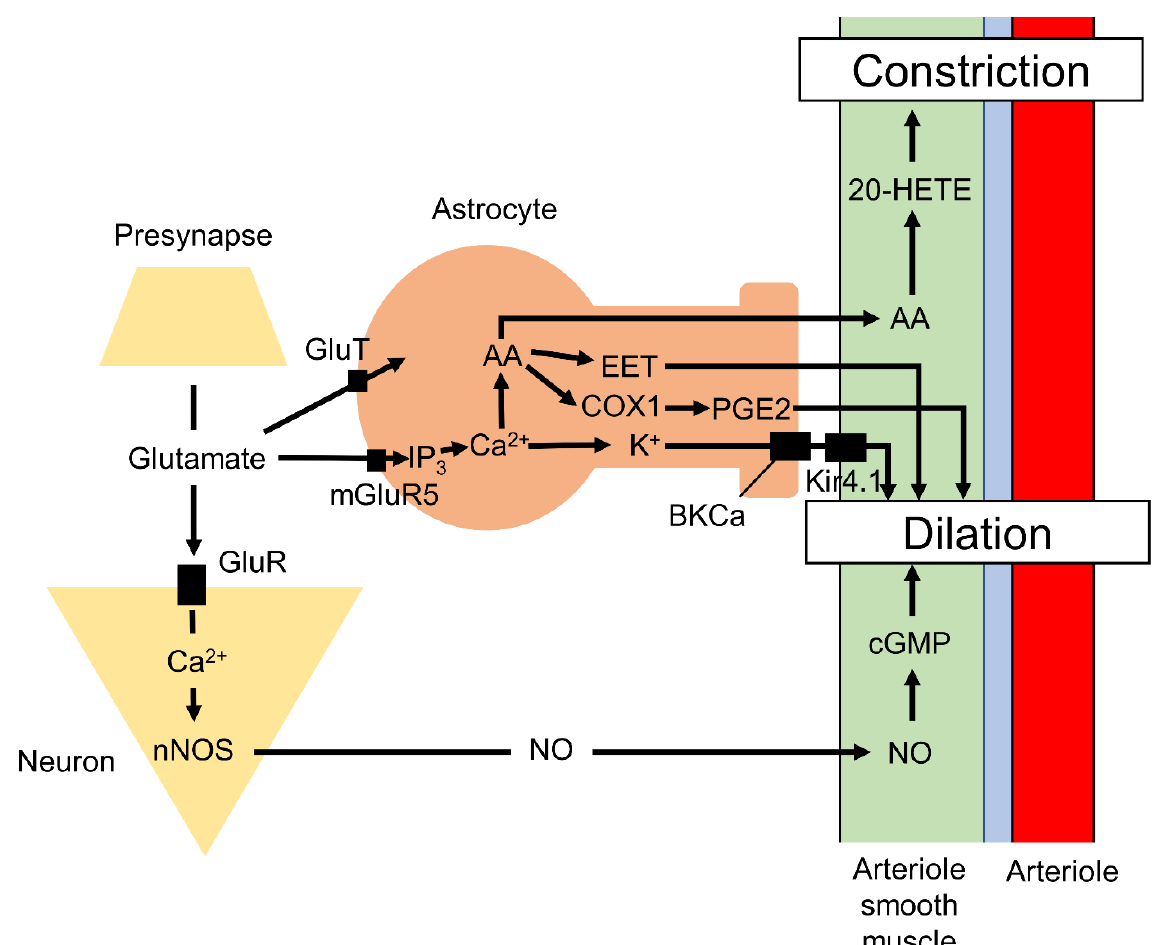
Figure 1. Schematic figure of the neurovascular coupling. Astrocytes and neurons intimately regulate the vasodilation and vasoconstriction of arterioles. AA, arachidonic acid; COX-1, cyclooxygenase-1; CSF, cerebrospinal fluid; EET, epoxyeicosatrienoic acids; GluT, glutamate/Na + -cotransporter; GluR, glutamate receptor; 20-HETE, 20-hydroxyeicosatetraenoic acid; IP 3 , inositol 1,4,5-trisphosphate; ISF, interstitial flow; Kir4.1, inward-rectifier potassium channels; NO, nitrogen oxide; nNOS, neuronal nitric oxide synthase.